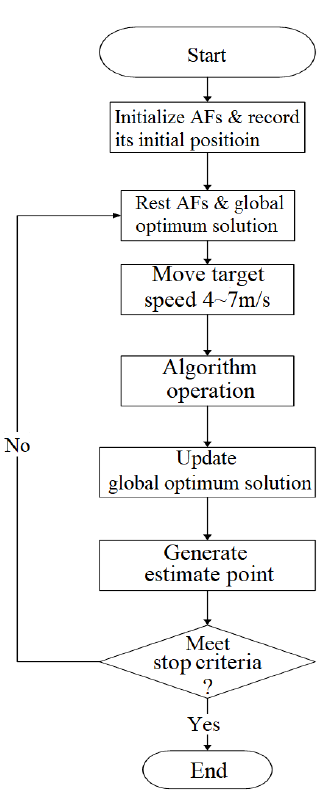
Figure 6. Flow chart of AFSA target tracking.